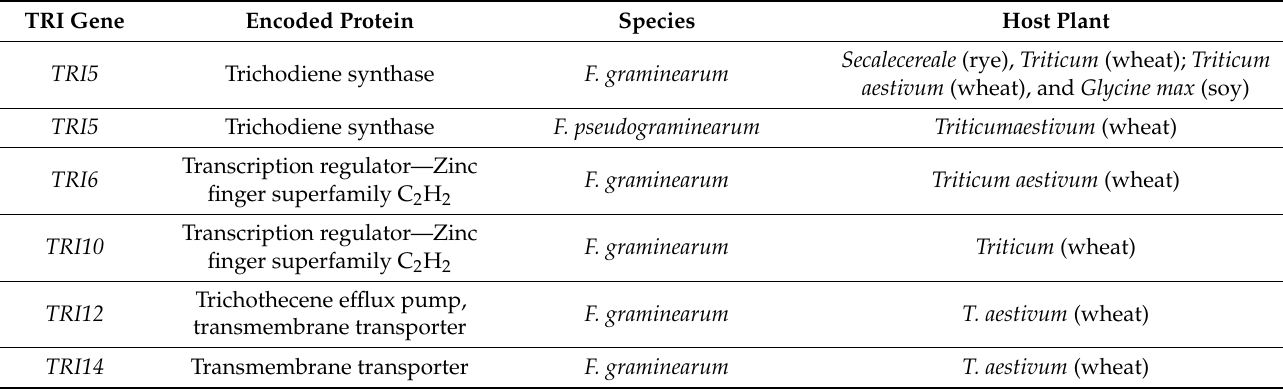
Table 3. Fusarium trichothecene toxin (TRI)